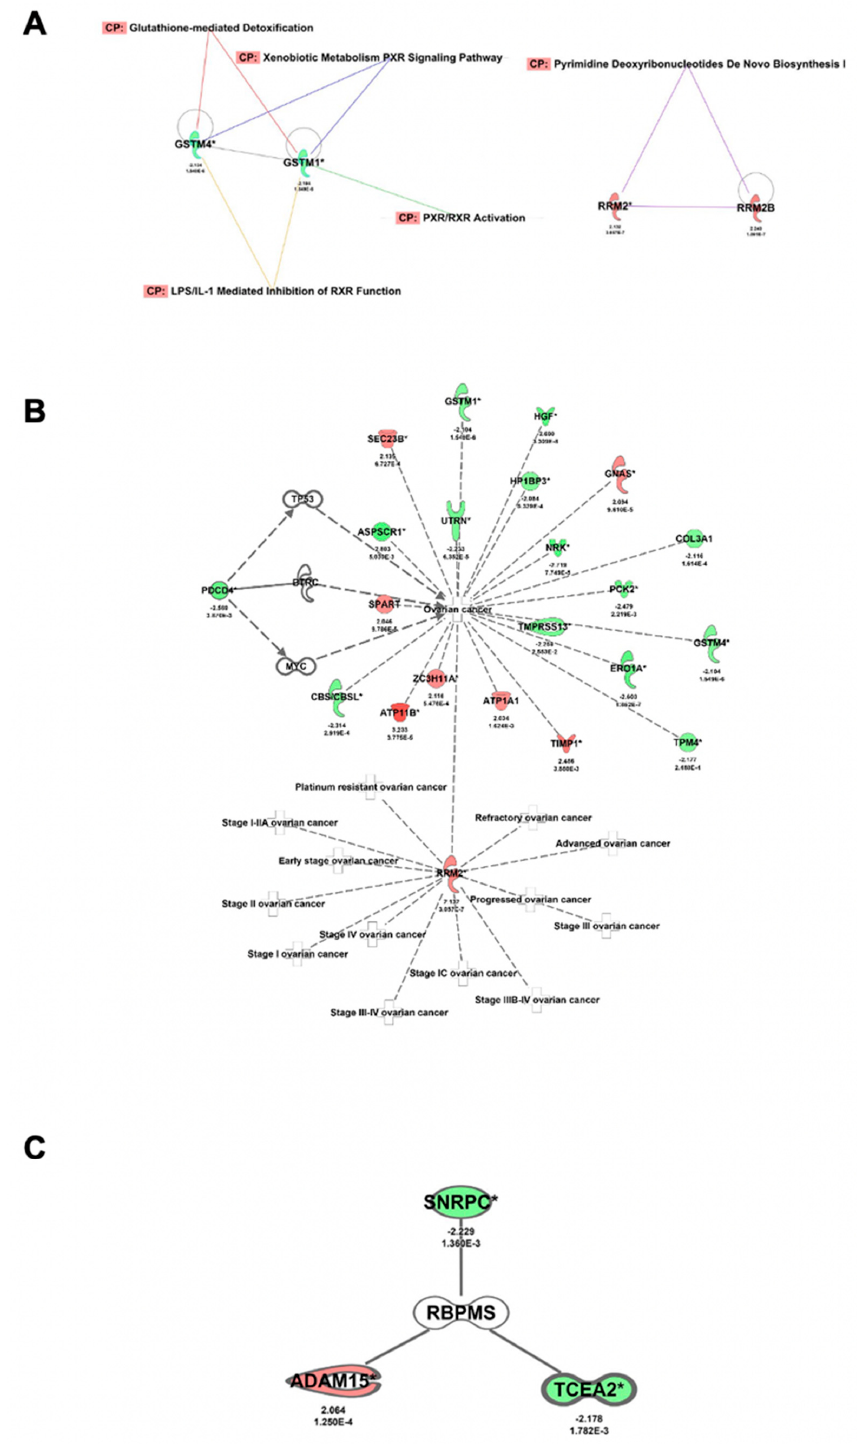
Figure 5. IPA of differentially abundant proteins in SG2 and EV clones: ( A ) Interactions between the top five canonical pathways of the proteomic studies. ( B ) Signaling pathway showing proteins associated with ovarian cancer. ( C ) A node showing three of the identified proteins directly interacting with RBPMS. Red color denotes increased protein levels; green color denotes reduced protein levels following RBPMS